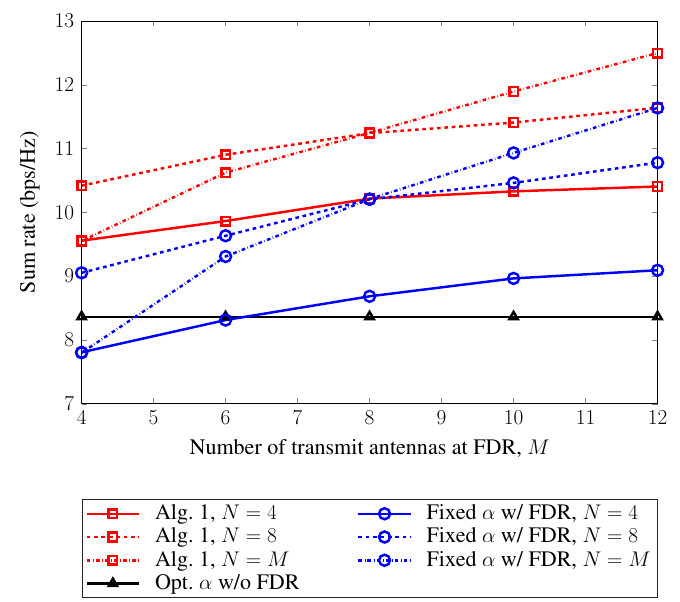
Figure 3. Sum rate of the secondary receiver (SR) and the primary receiver (PR) versus P p with M = N = 4.